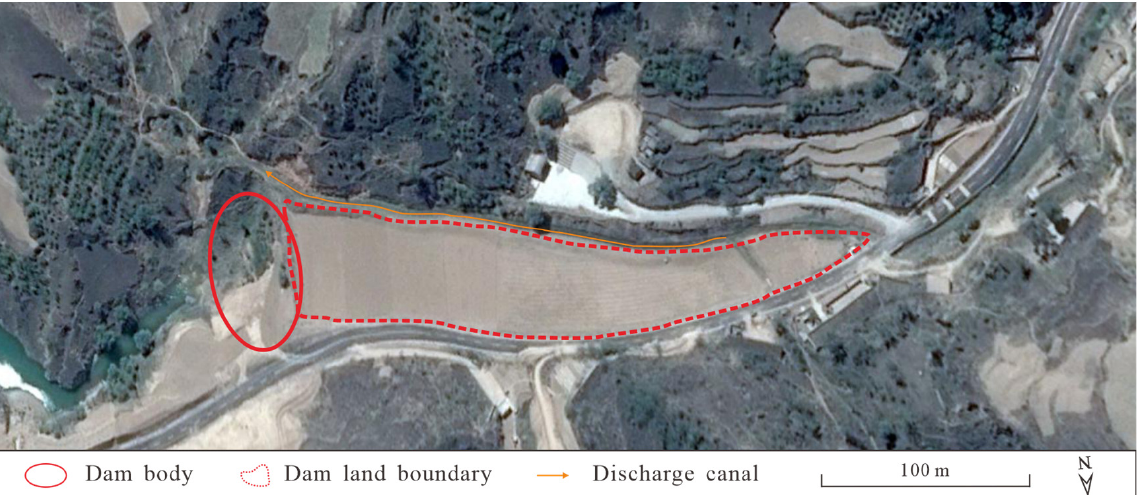
Figure 6. Check dam with a discharge canal.